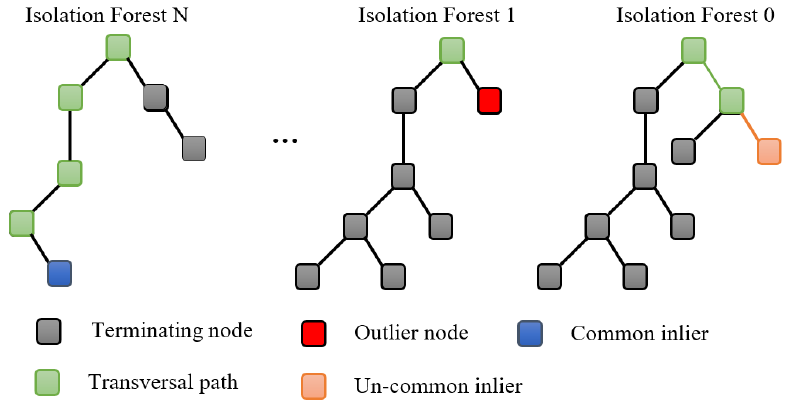
Figure 5. Illustration of anomaly detection using the Isolation Forest